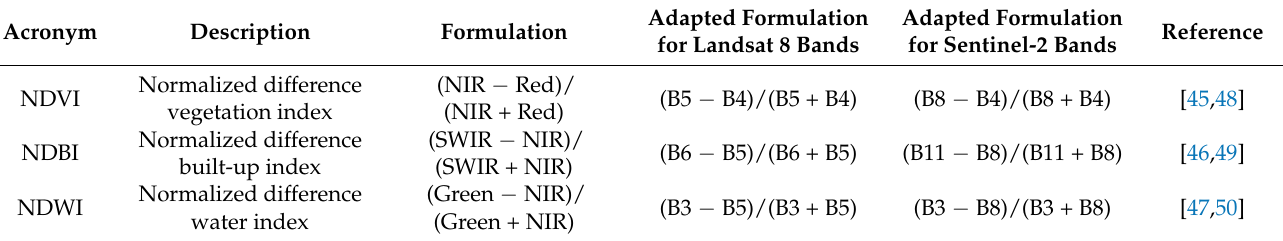
Table 1. Land cover indices used for LST downscaling.